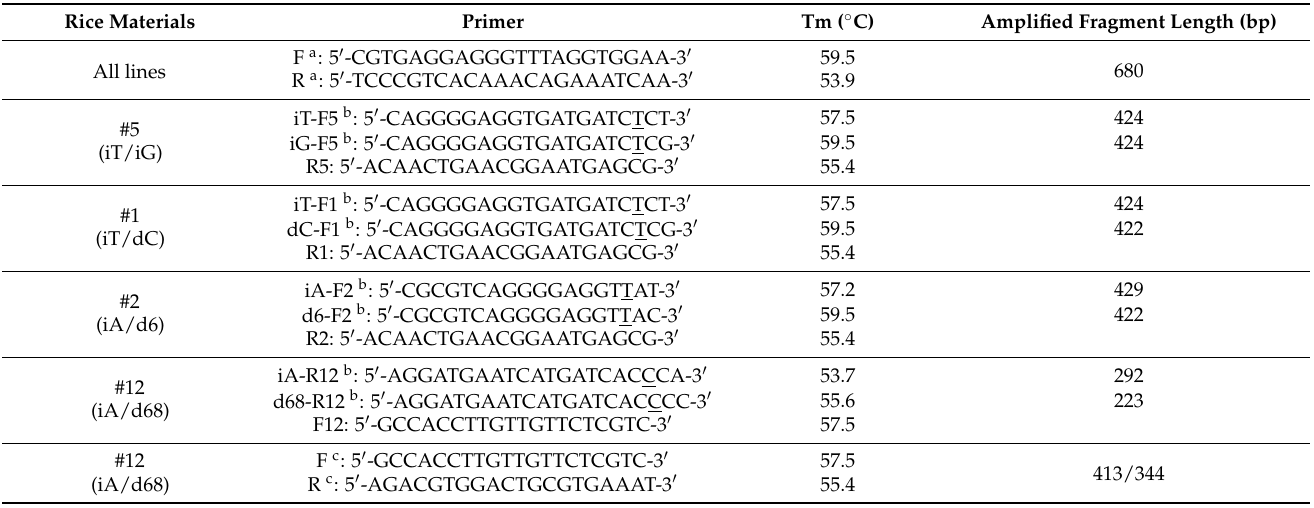
Table 1. Primers for detecting offspring plant genotypes of bi-allelic mutant lines.